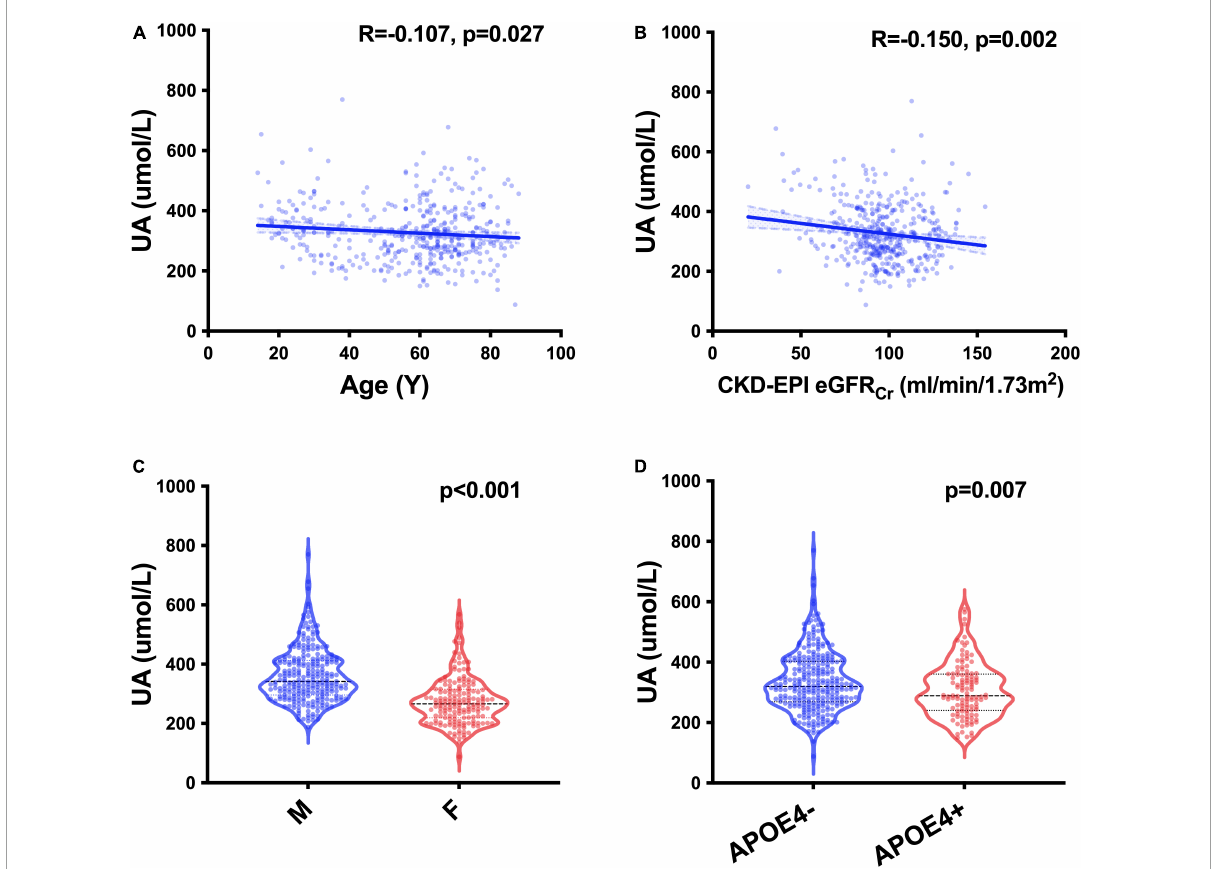
FIGURE1 UA-related factors. Spearman’s correlation analysis between the levels of sUA and age (A) and CKD-EPI eGFR Cr (B) ; Mann–Whitney U test of the levels of sUA grouped by sex (C) and the status of APOE ε 4 carriers (D) .